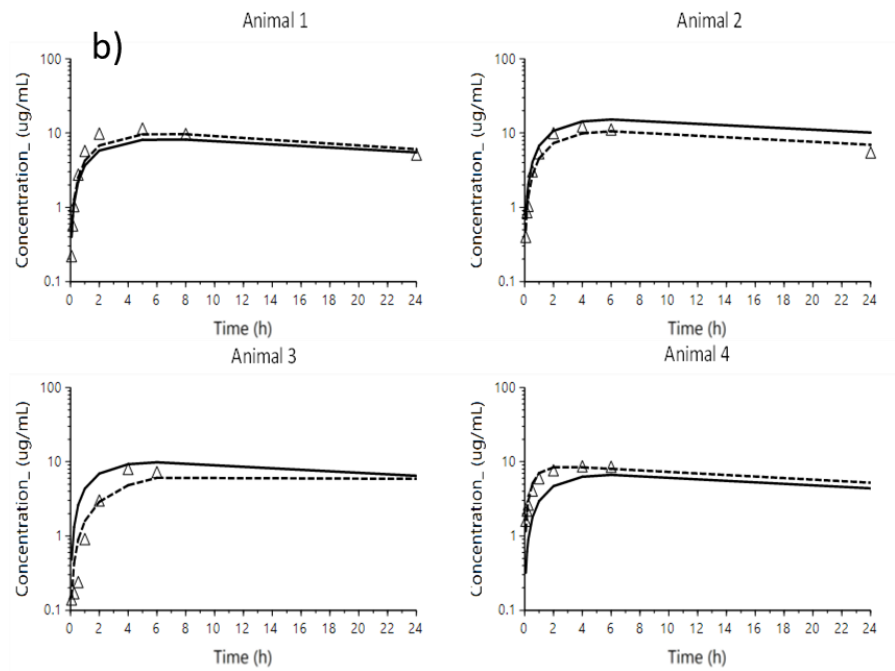
Figure 2. Plots of overlayed observed (triangles), individual predicted (dashed line) and population (solid line) predicted concentrations by the model vs. time profiles, sorted by animal after IV (( a ) panel) and IM (( b ) panel) administrations.